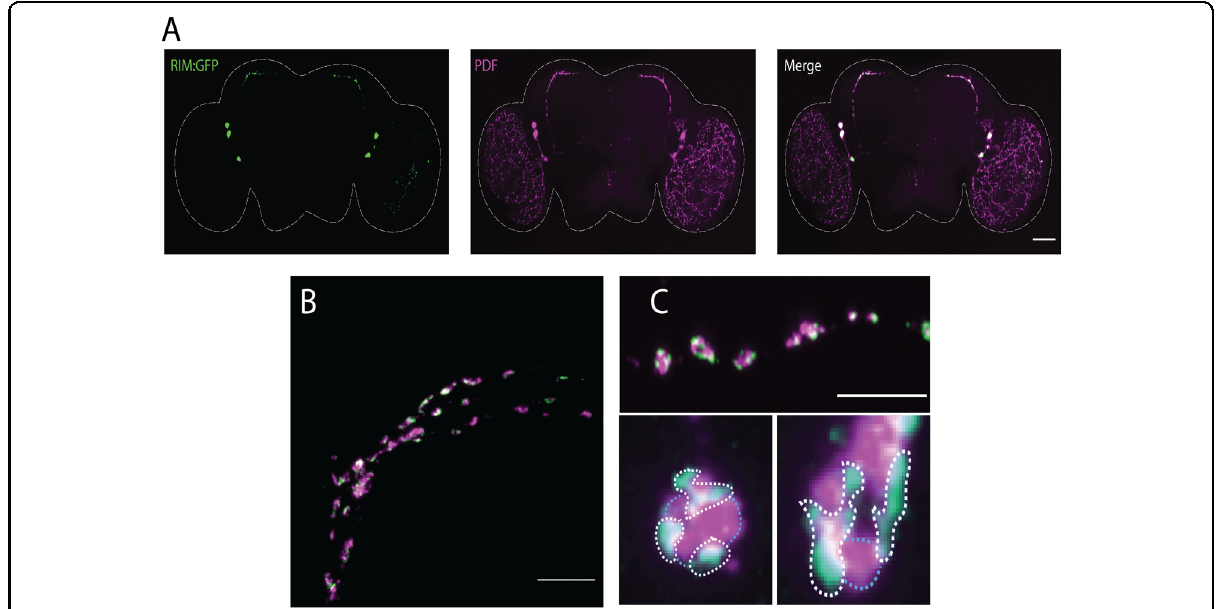
Fig. 5 Rim:GFP was found near but not with PDF in s-LNvs dorsal terminals. A Expression of a GFP-tagged version of Rim was driven in the LNvs using the PDF-GAL4 driver (in the green, left panel) while PDF was assessed by immunohistochemistry (in magenta, central panel). A merge of images is observed at the right panel. Distribution of Rim:GFP was found to be mostly localized to the soma of the small and large LNvs while also detected in the dorsal projection of the s-LNvs. B Higher magni fi cation of the sLNv terminals showed Rim:GFP and PDF were not completely colocalized. C Rim:GFP (green) was occasionally found to co-localize (white) with PDF (magenta). Closer inspection of high magni fi cation images (bottom panels) revealed that Rim:GFP formed aggregates (identi fi ed by white dotted line), mostly not co-localizing with PDF (shown in light blue dotted line). Scale bar is 50 μ m in A and 10 μ m in B and C